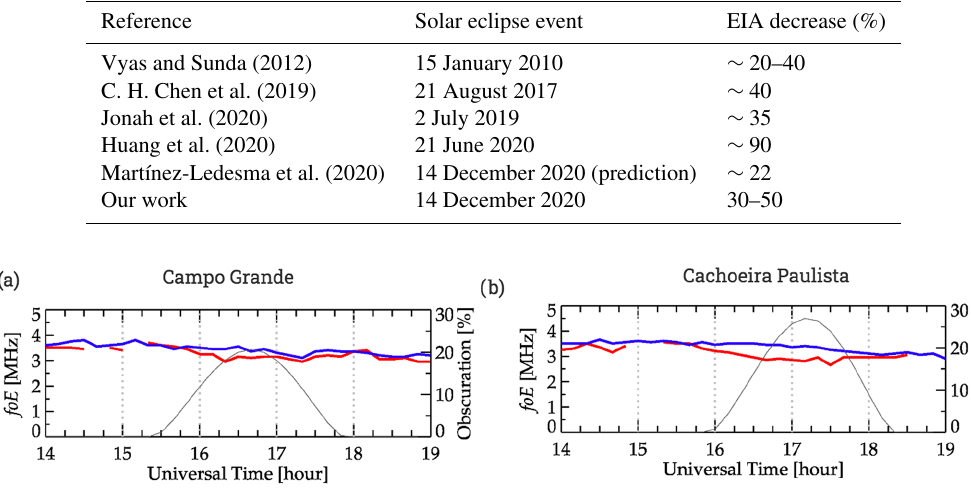
Table 1. Some studies that observed the EIA decrease during the solar eclipse events, as well as the percentage of the EIA layer decrease. Reference